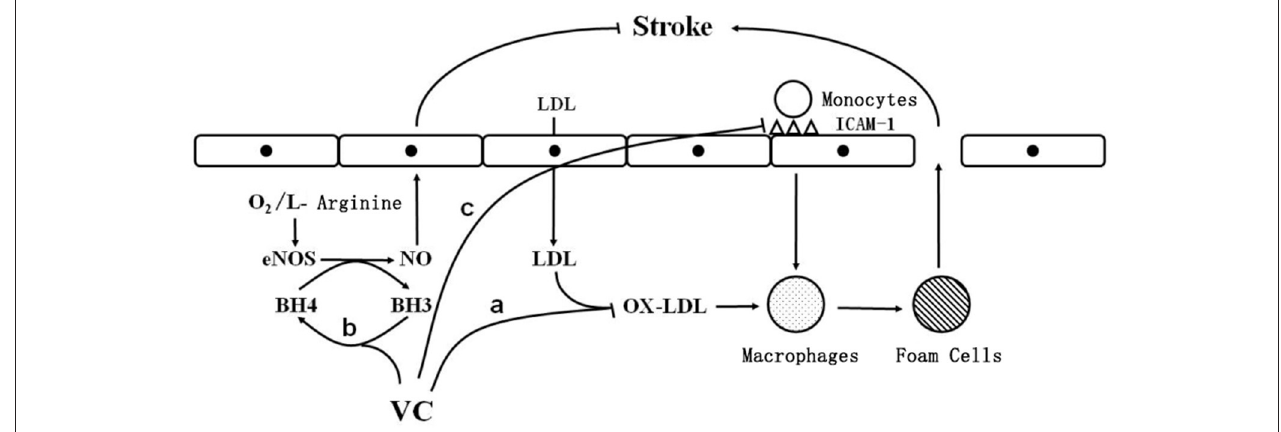
FIGURE 1 | The cellular mechanism by which vitamin C reduces the risk of ischemic stroke. O 2 : oxygen; eNOS: endothelial nitric oxide synthase; BH3: trihydrobiopterin; BH4: tetrahydrobiopterin; vc: vitamin C; NO: nitric oxide; LDL: low density lipoprotein; OX-LDL: oxidized low density lipoprotein; ICAM-1: intercellular adhesion molecule-1; stroke: stroke; a: vitamin C inhibits low-density lipoprotein oxidation; b: vitamin C reduces trihydrobiopterin to tetrahydrobiopterin; c: Vitamin C reduces the expression of ICAM-1.